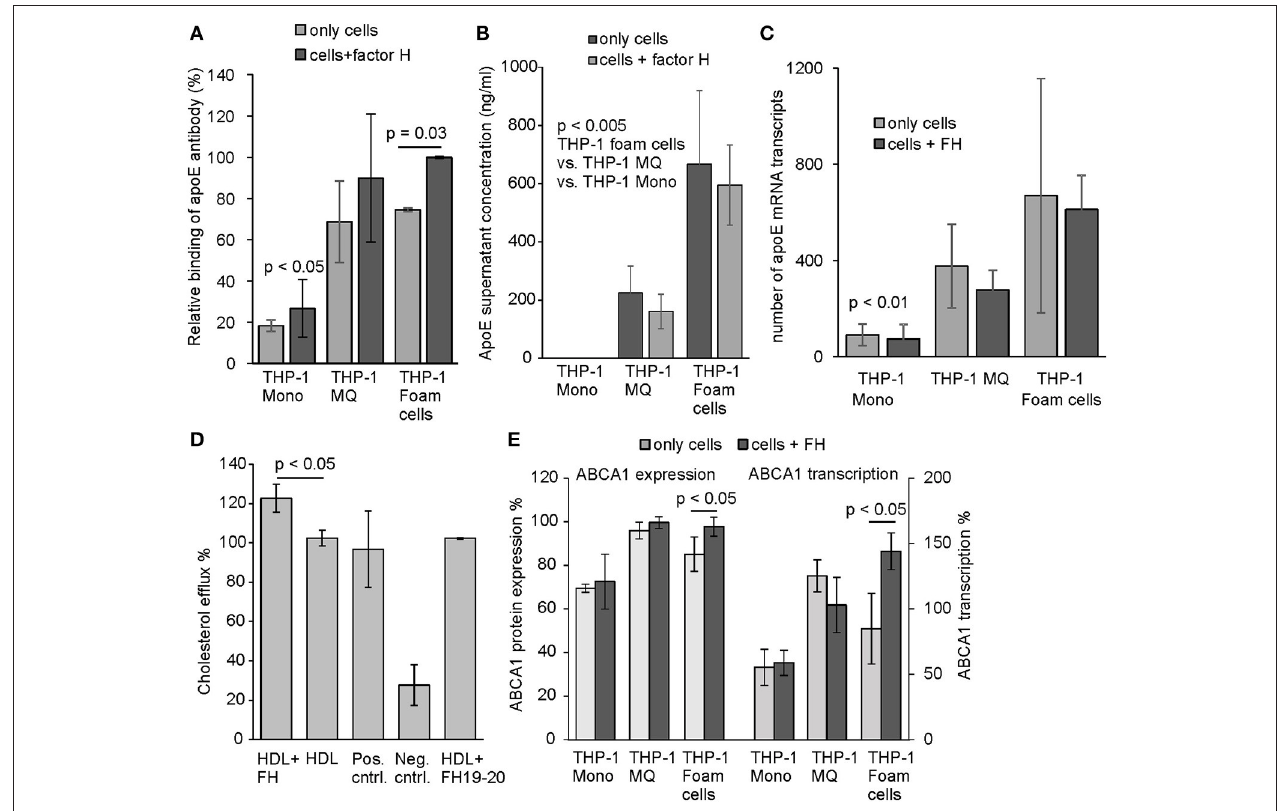
FIGURE 5 | Binding, secretion, and expression of apoE and cholesterol efflux by THP-1 cells. (A) Surface expression of and/or binding of apoE from culture supernatants to THP-1 monocytes, THP-1 macrophages and cholesterol-loaded THP-1 cells detected by anti-apoE antibody. Cells were incubated with and without FH for 24h. Next, the cells were washed and detached from the tissue culture plates. Presence of apoE on cell surfaces were detected using anti-human apoE and Alexa 488 labeled goat anti-rabbit antibody in flow cytometry. ApoE binding is shown as relative to the maximum intensity in each individual experiment ( n = 3). (B) Secretion of apoE to cell culture media by THP-1 monocytes, THP-1 macrophages and cholesterol-loaded THP-1 cells detected by ELISA ( n = 4). (C) Number of apoE mRNA transcripts analyzed by sequencing the cell isolated mRNA ( n = 4) (D) Cholesterol efflux from non-loaded THP-1 macrophages labeled with fluorescent cholesterol in the presence or absence of FH ( n = 3). Cholesterol efflux in the presence of equal molarity of FH19-20 is shown. The positive (Pos. cntrl. from Abcam) and non HDL treated controls (Neg. cntrl.) were included in the assay. (E) Protein expression and transcription levels of ABCA1 in THP-1 monocytes, THP-1 macrophages and cholesterol-loaded THP-1 cells detected by anti-ABCA1 antibody and mRNA sequencing. Levels are calculated as relative to the protein expression and transcription in THP-1 macrophages ( n = 4). Statistical significance calculated using Mann-Whiney U -test or one-way ANOVA supplemented with Tamhane’s multiple comparison test. Error bars indicate